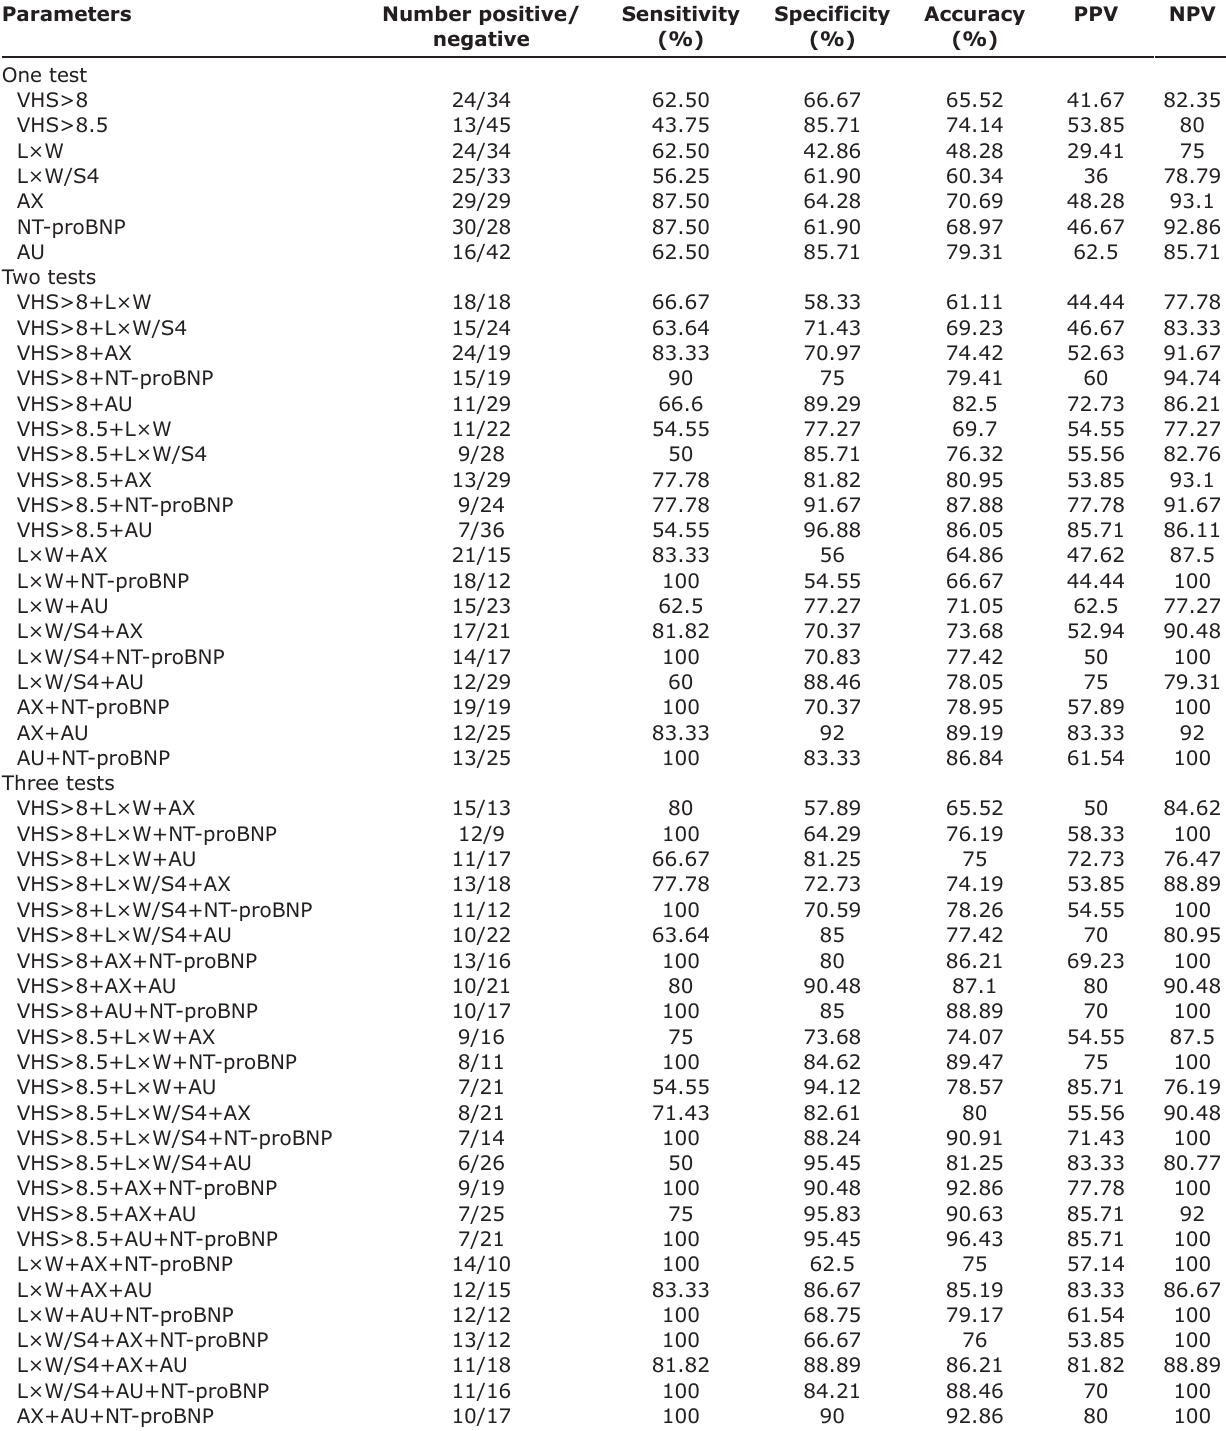
Table-2: Specificity, sensitivity, accuracy, positive predictive, and negative predictive values of tests for distinguishing cats with (n=16) and without hypertrophic cardiomyopathy (n=42).